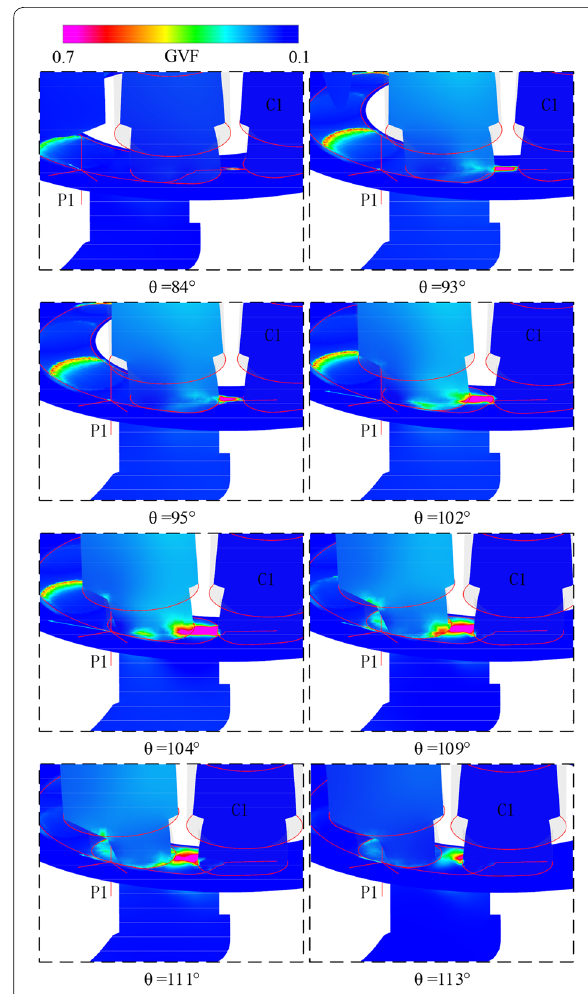
Figure 8 Gas volume fractional cloud diagram on cross section I and